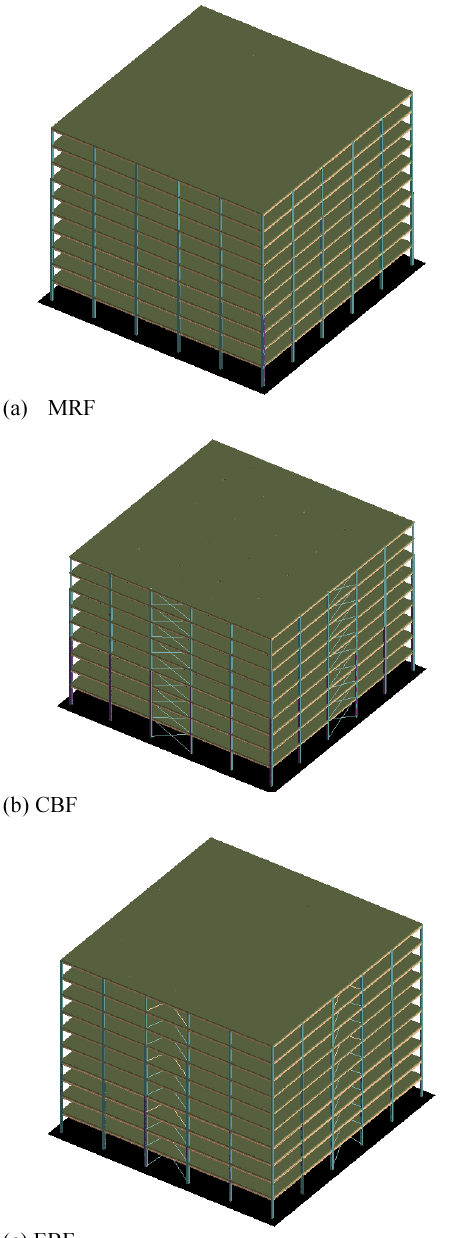
Table 2. Member designs for Concentrically Braced Frame